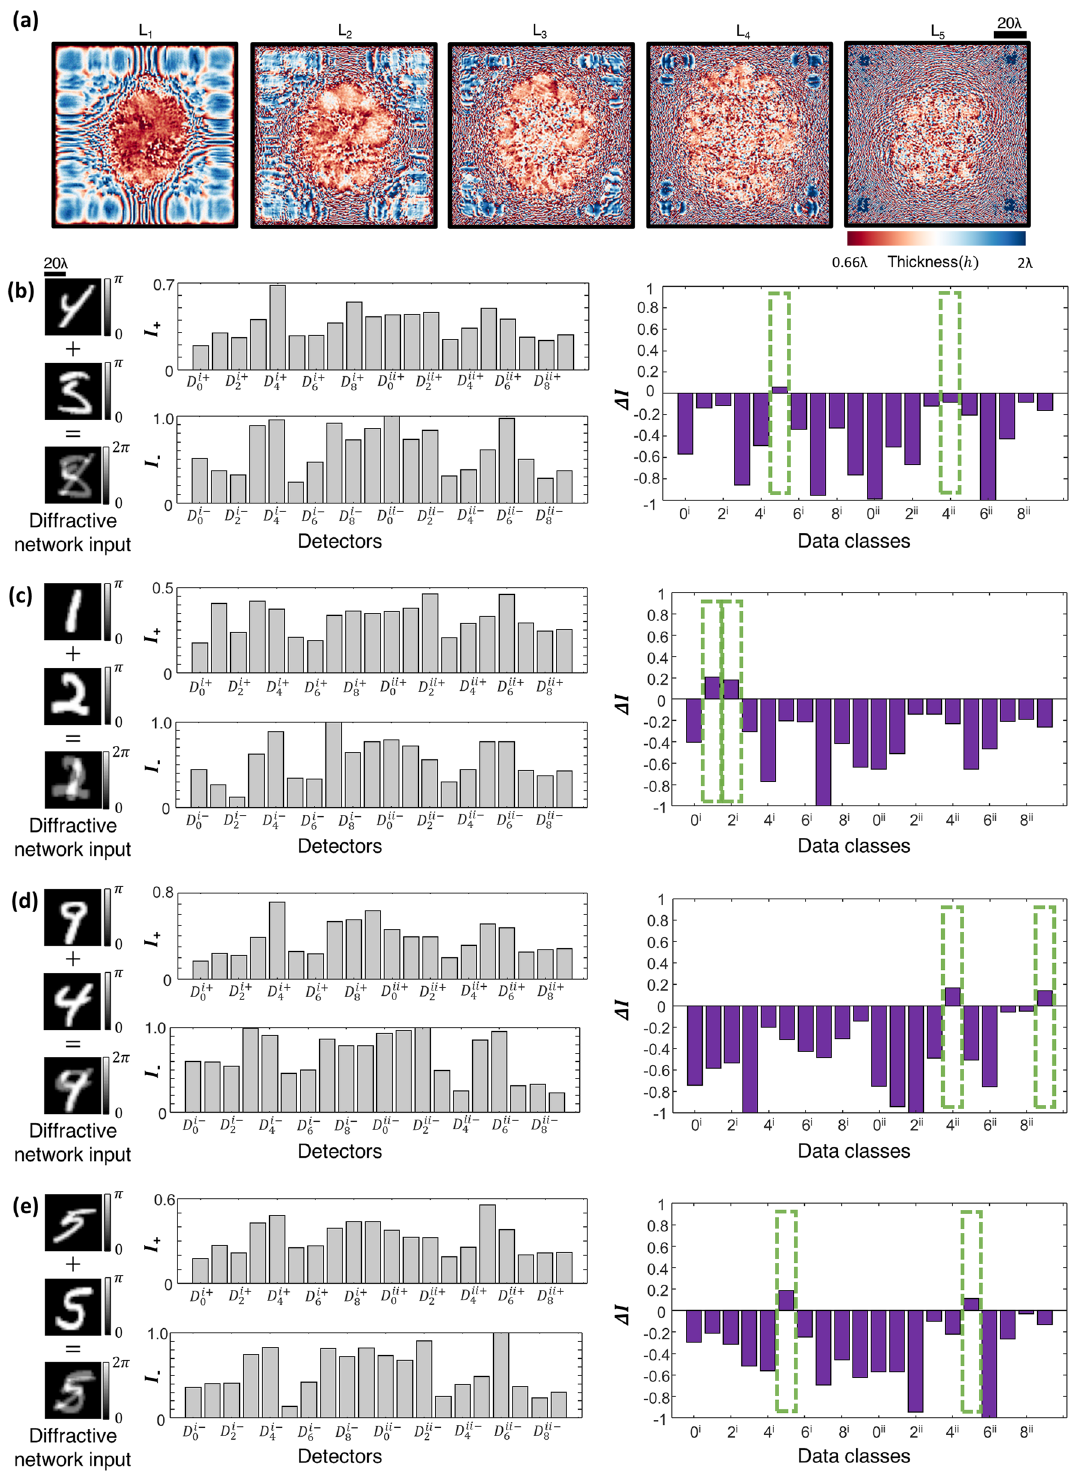
Figure 3. All-optical classification of spatially-overlapping phase objects using the diffractive optical network D 2 NN-D1d, based on the detector layout scheme D-1d shown in Fig. 1c. ( a ) The thickness profiles of the diffractive layers constituting the diffractive optical network D 2 NN-D1d at the end of its training. This network achieves 85.82% blind inference accuracy on the test image set T 2 . ( b – e ), Left: Individual phase objects (examples) and the resulting input phase distribution created by their spatial overlap at the input field-of-view. Middle: The normalized optical signals, I + and I − , synthesized by D 2 NN-D1d at its output detectors. Right: The resulting differential signal, (cid:31) I = I + − I − . The largest two differential optical signals correctly reveal the classes of the overlapping input phase objects (indicated with the green rectangular